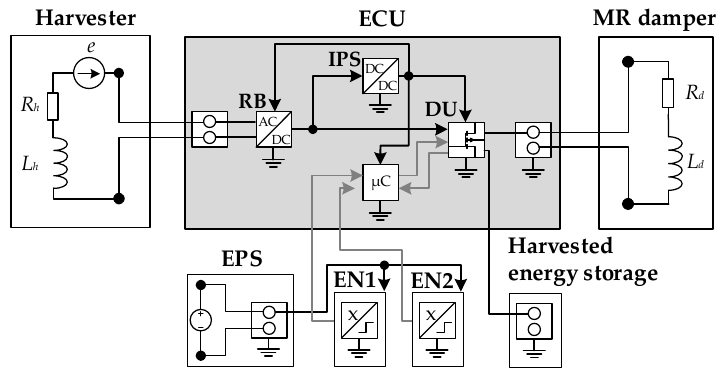
Figure 9. Connections in the harvester–electrical control unit–MR damper system.